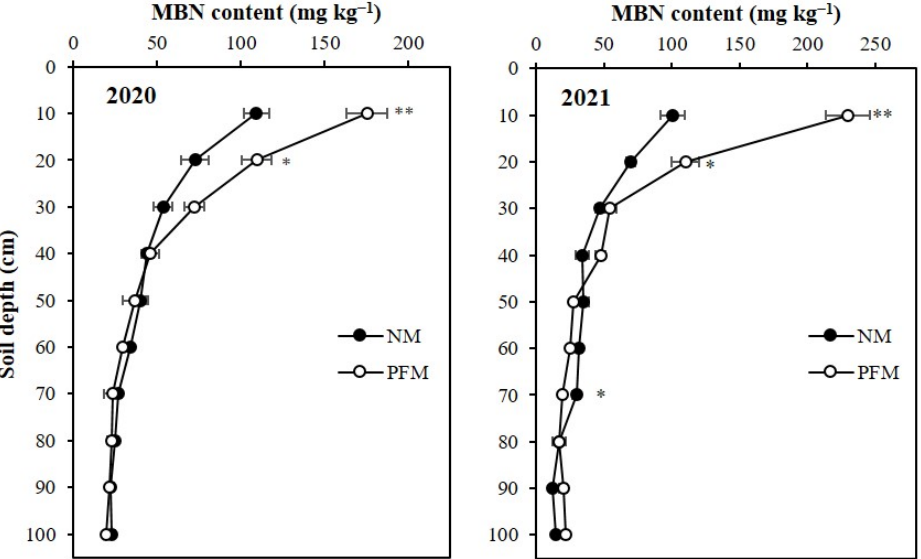
Figure 3. Effects of plastic film mulching and no-mulching treatments on the depth distribution of microbial biomass N (MBN) in the soil profile. ** Significant differences between treatments at p < 0.01, * significant differences between treatments at p < 0.05. 2020, soil sampling at final harvest in